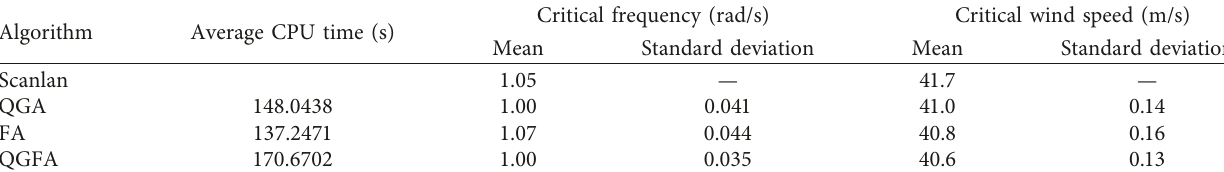
Figure 8: Flutter derivatives in Case III. Table 6: Comparison of computational results (Case III).